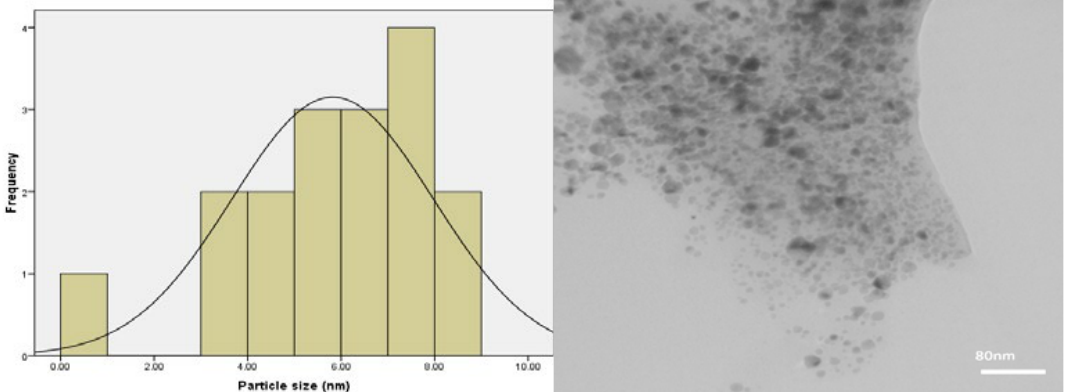
Fig. 4. TEM images of palladium oxide nanoparticles and Histogram of particle size of Pd